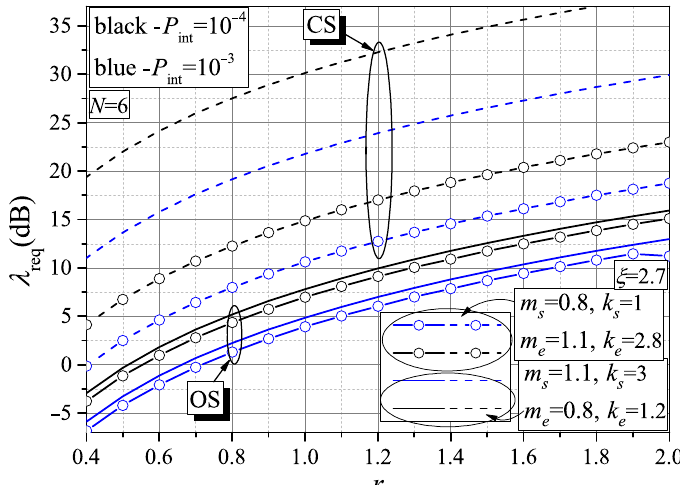
Figure 6. Required MER vs. the distances among the active nodes in the eavesdropped WSN.